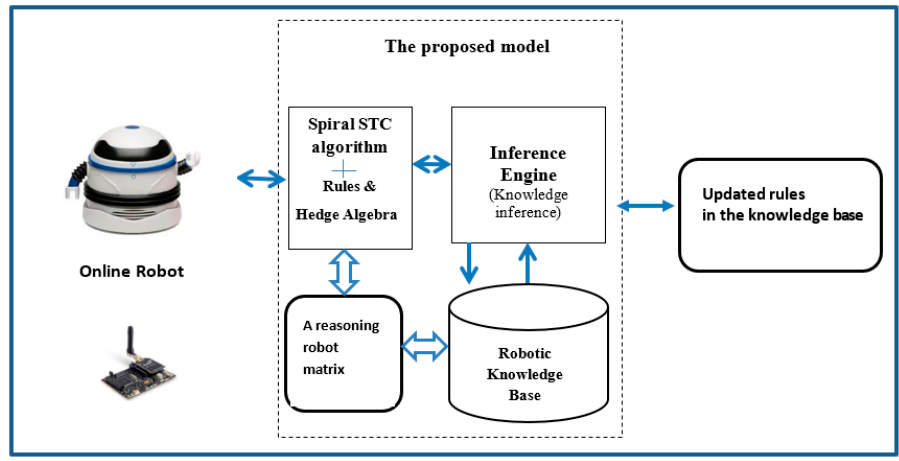
Figure 4. The proposed model.